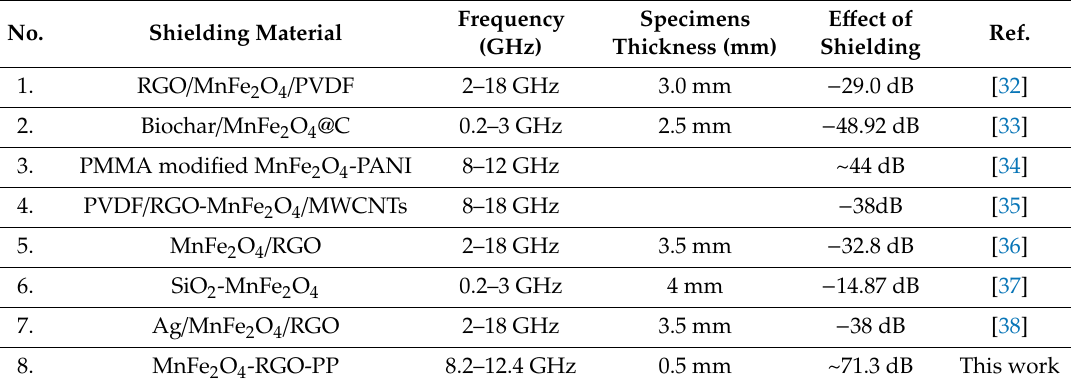
Table 2. Comparison of electromagnetic wave absorption performance between MnFe 2 O 4 spinel ferrite nanoparticles based developed composites reported in recent